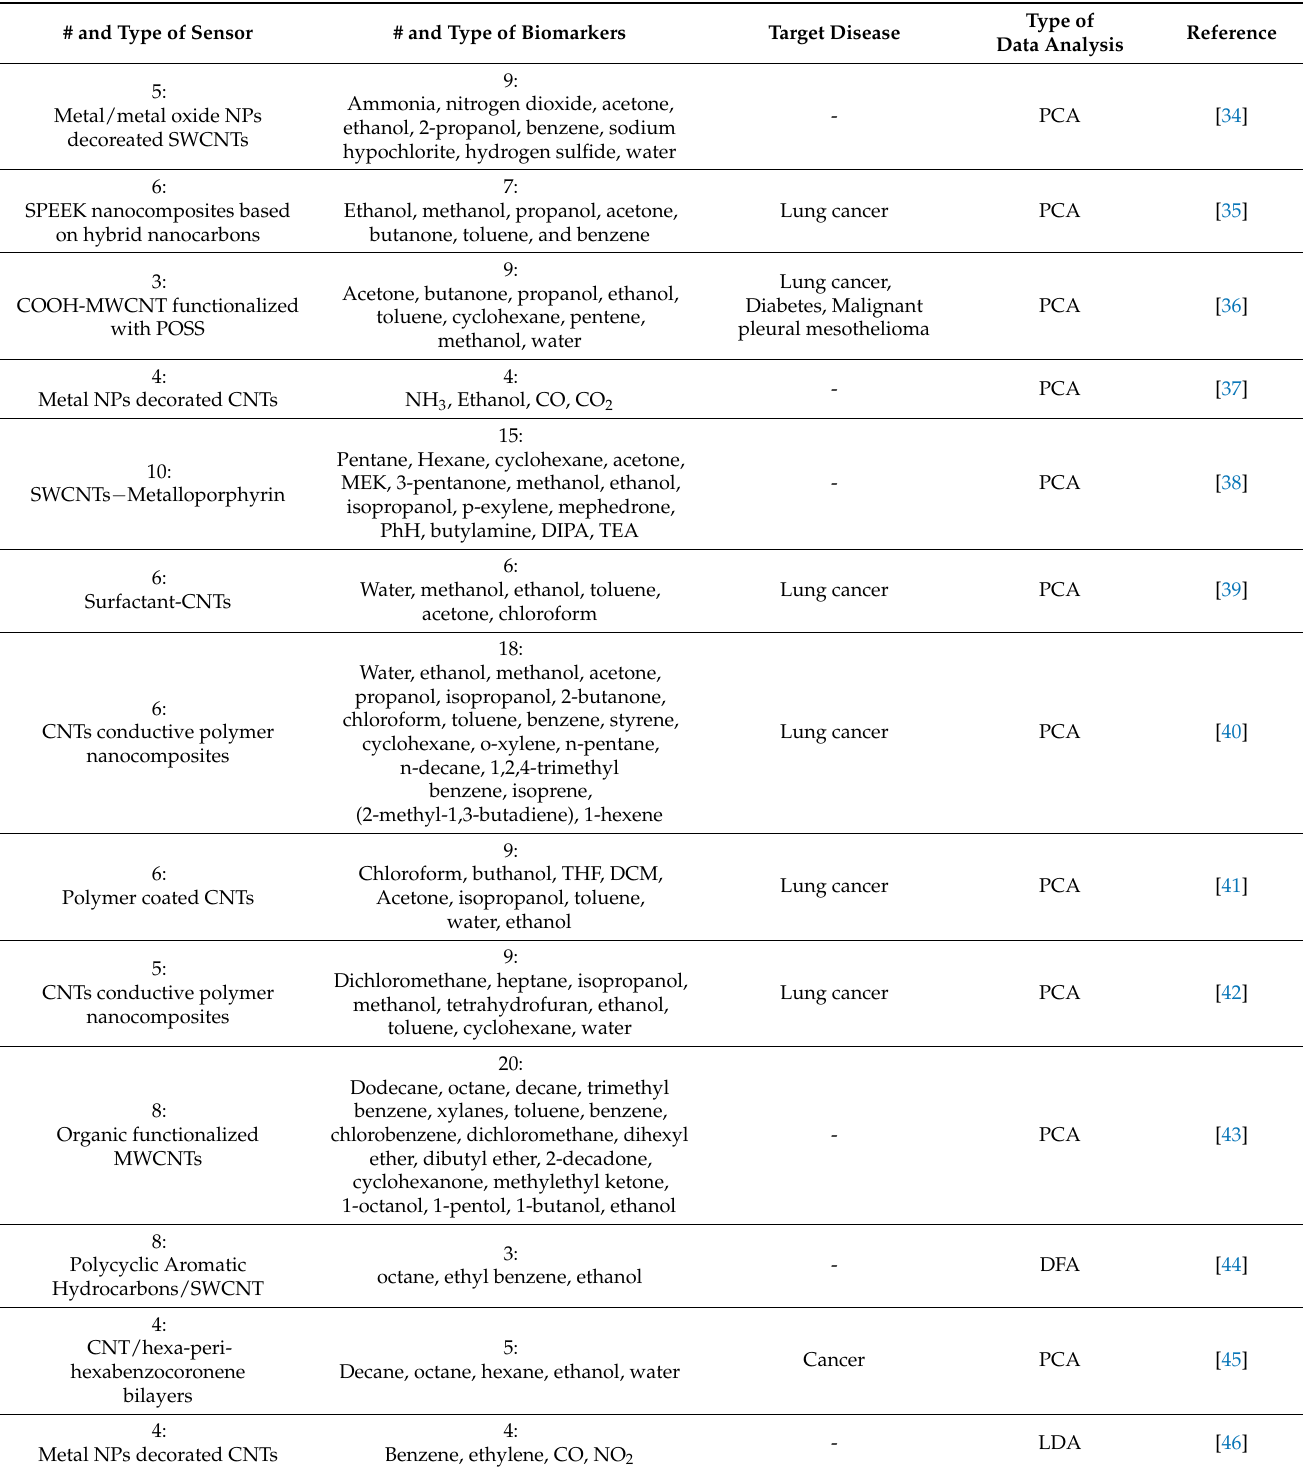
Table 3. Number and type of the sensors in the electronic nose based on CNTs, number and type of biomarkers investigated, target disease, and type of data analysis. # =